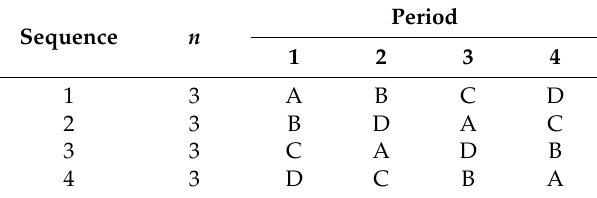
Table 1. The Latin square design for four treatments 1 .